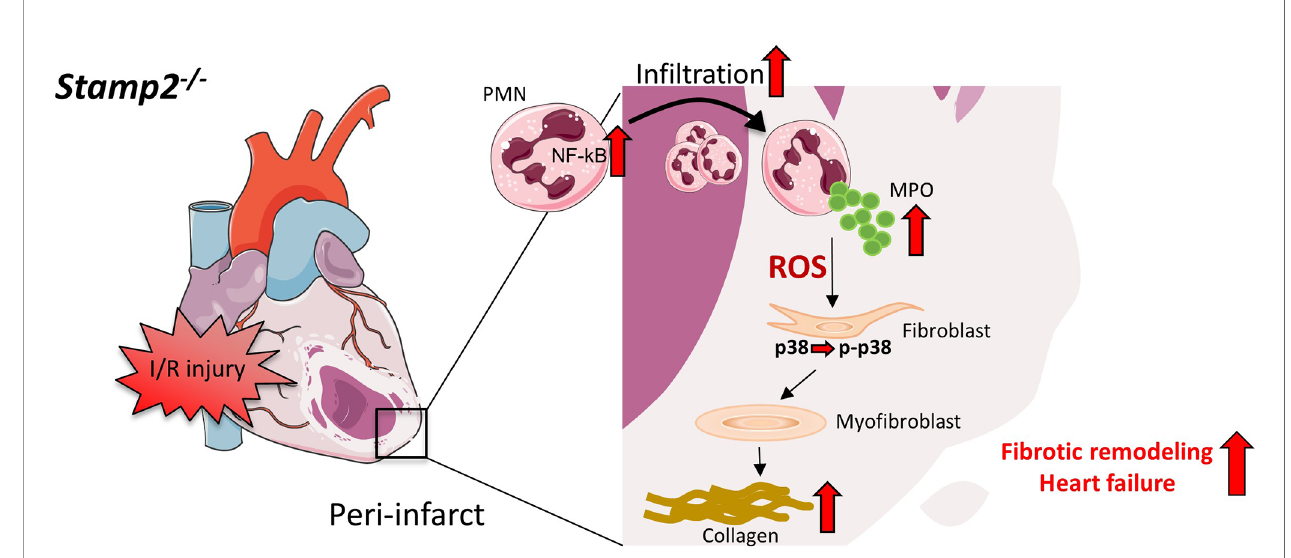
FIGURE 6 | Schematic overview of PMN activation and fi brotic remodeling in Stamp2 -/- mice after I/R. Stamp2 de fi ciency results in NmRal-mediated proin fl ammatory NF- k B activation (11, 15) which subsequently induces enchanced myocardial PMN in fi ltration after I/R injury. PMN degranulation and MPO secretion are elevated in Stamp2 -/- PMN, thereby activating the p38-MAPK pathway and inducing fi broblast-to-myo fi broblast transdifferentiation. In turn, enchanced collagen deposition promotes maladaptive structural remodeling fi nally leading to loss of LV function. PMN: polymorphonuclear neutrophils, Stamp2: six transmembrane protein of prostate 2, NF- k B: nuclear factor ‘ kappa-light-chain-enchancer ’ of activated B-cells, NmRal: NmrA-like family domain- containing protein 1, MPO: myeloperoxidase, p-p38/p38: phosphor / p38 MAP kinase. Figures were produced using Servier Medical Art